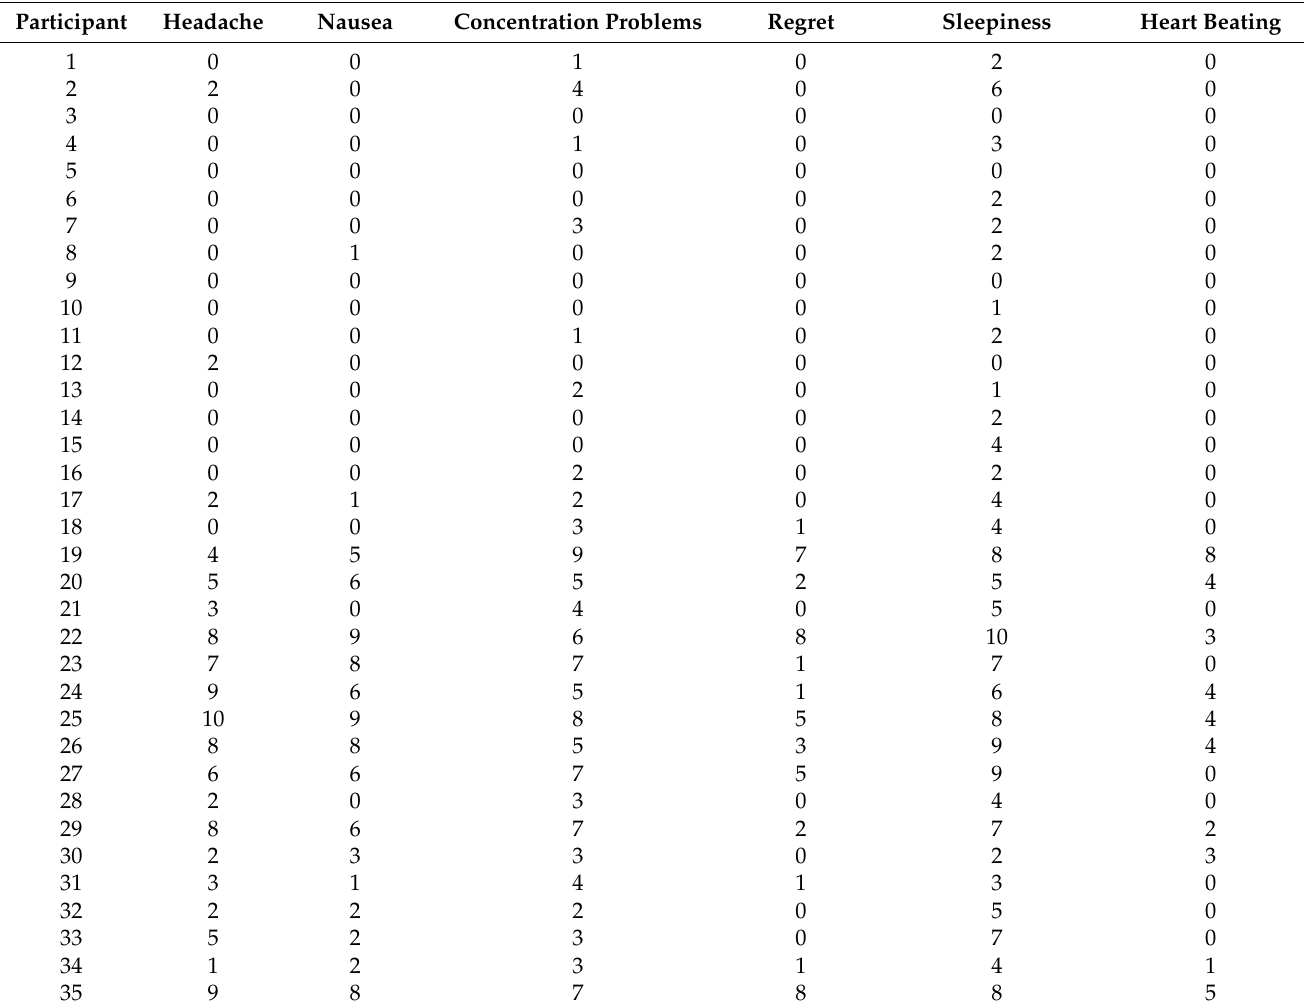
Table A4. Individual hangover symptoms, assessed on the alcohol day—individual participant